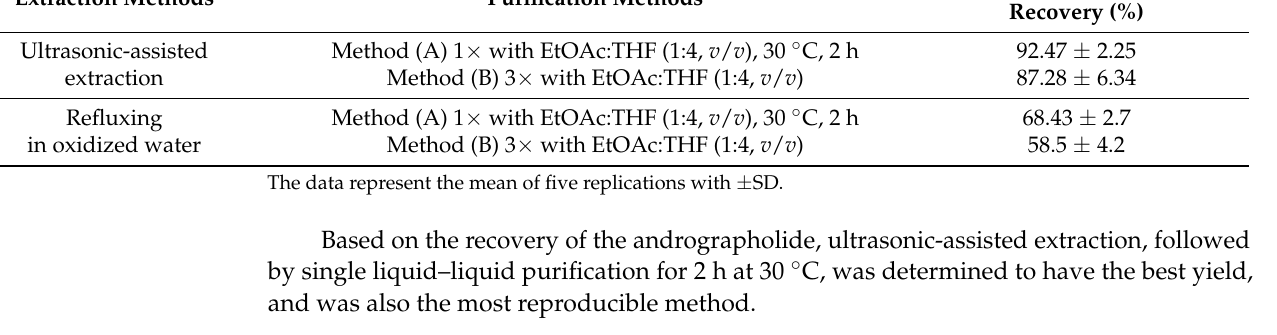
Table 1. Recoveries of the internal standard andrographolide added to G. biloba leaf extracts obtained with two extraction and two purification